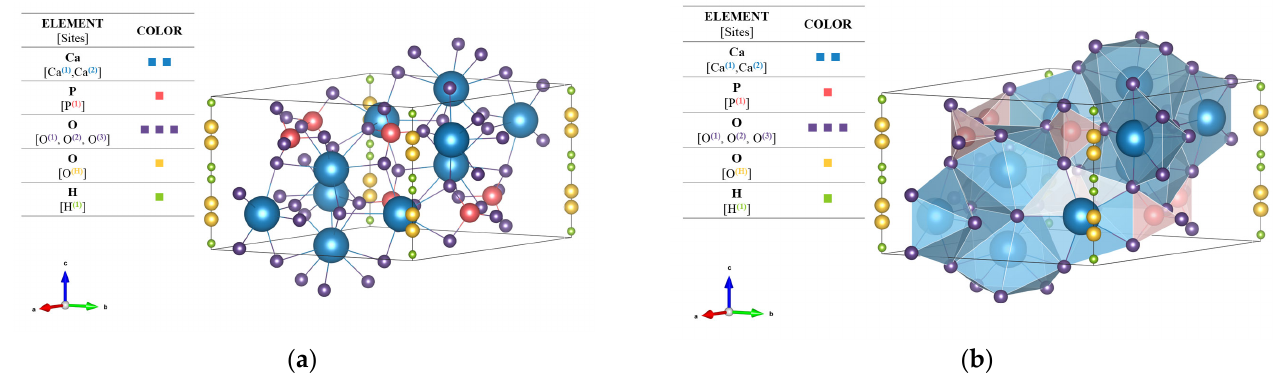
Figure 3. FT − IR Spectra for all HAp ‐ based materials. Table 3. FT − IR Spectroscopy for HAp ‐ based materials. Wavenumber (cm - 1 )